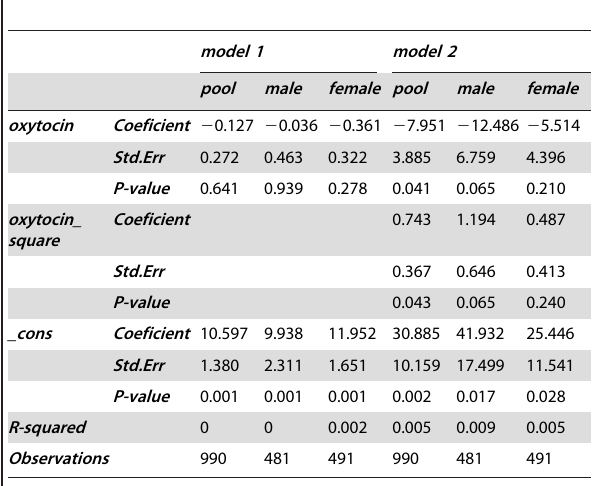
Table 1. Regression results for linear and nonlinear relationship between plasma oxytocin and trust.